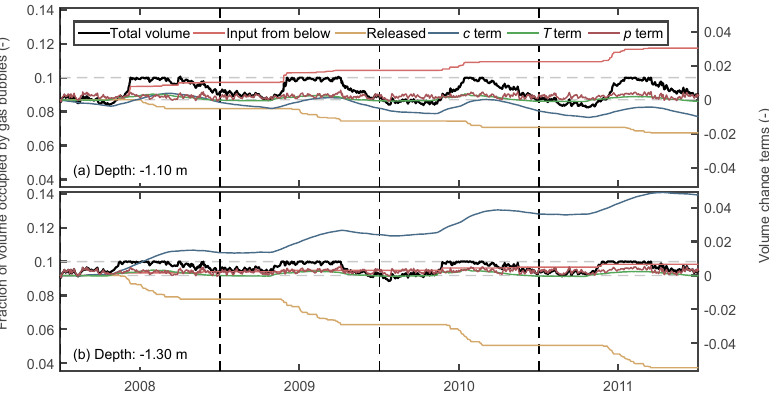
Figure 4. Fraction of volume occupied by gas bubbles at two example depths calculated with the EBG approach. Black lines show the modelled volume (left y axis) and the other continuous lines (right y axis) show the terms causing the volume changes. Therefore, the sum of the lines in colour yield the changes in the black line at every time step. The light grey dashed line highlights the volume threshold = 0 . 1), after which additional volume increase was released in an ebullition ( f V max